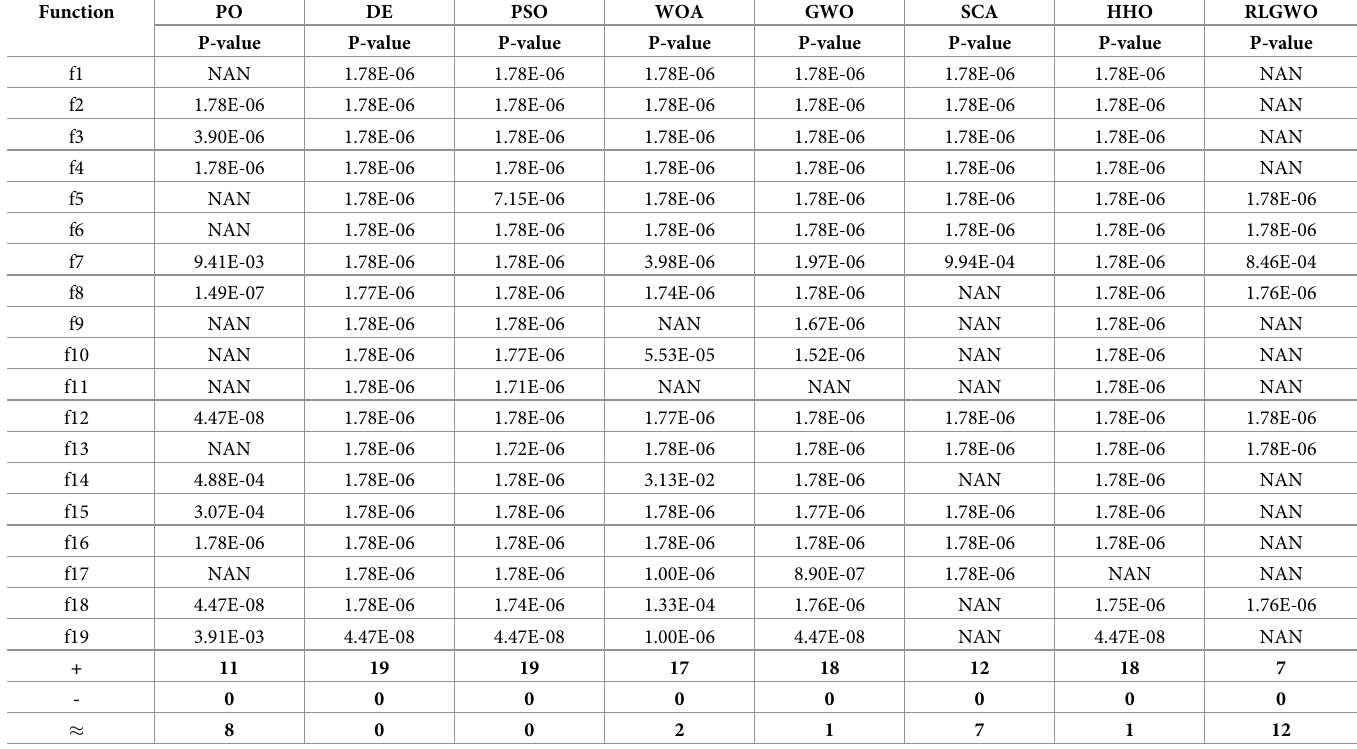
Table 5. p-values of the Wilconxon rank-sum test at 0.05 significance level for CRLPO against other eight algorithms on 19 benchmark functions from Table 1 with 100 dimensions.